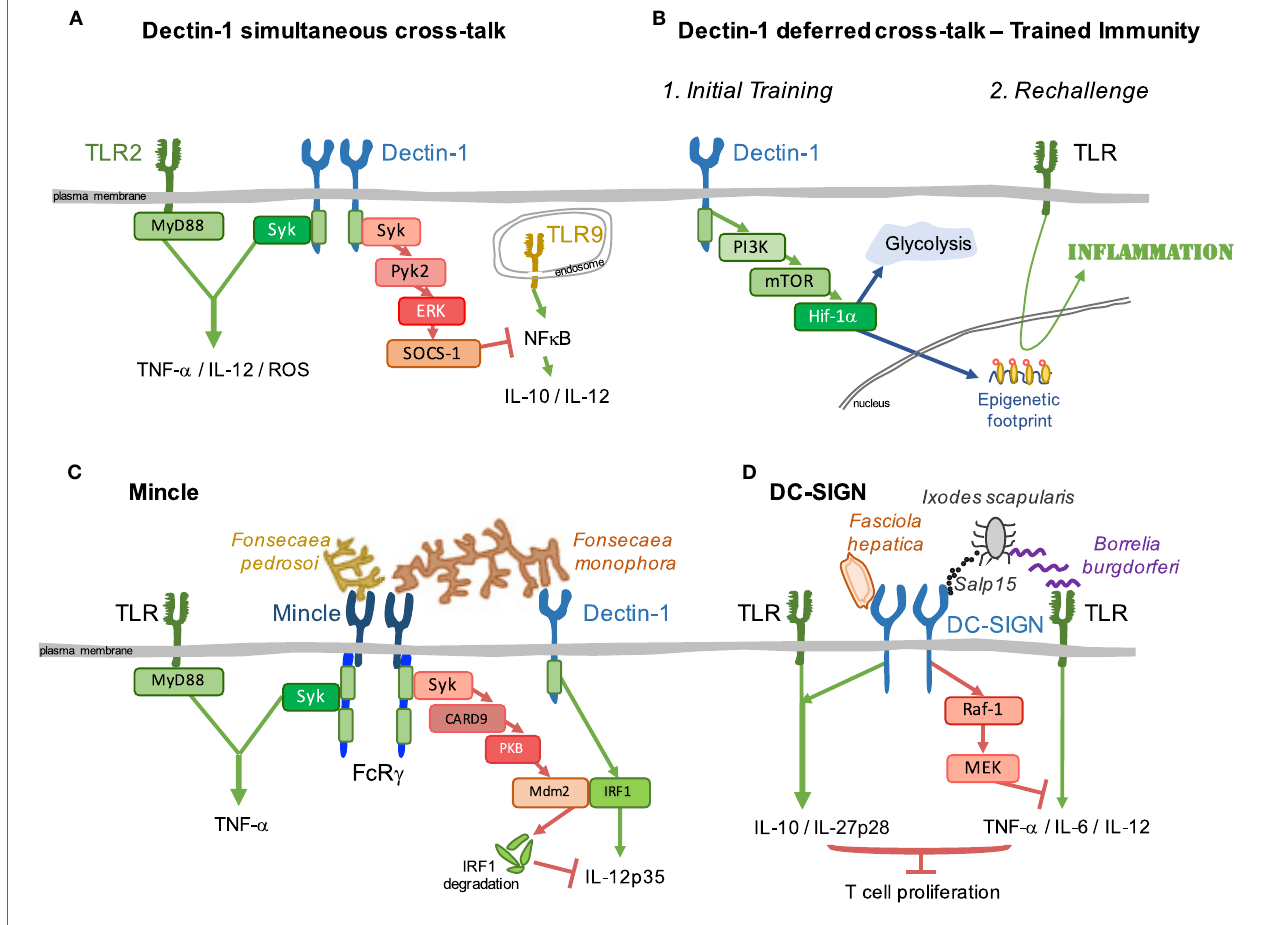
FiGURe 3 | Signaling crosstalk between myeloid C-type lectins and heterologous receptors. Signaling pathways initiated downstream of C-type lectin receptors (CLRs) interact with surrounding cascades triggered by heterologous receptors. Examples of such crosstalk are illustrated. (A) Dectin-1 coordinates with simultaneous signals from diverse TLRs to modulate the inflammatory response; this interaction can be either positive, as for TLR2/MyD88 (left), or negative, as for TLR9 through a Pyk2/ERK/SOCS-1-dependent pathway (right). (b) In addition, the axis Dectin-1/PI3K/mTOR/Hif-1 α generates a switch toward glycolytic metabolism together with an epigenetic footprint, allowing for a “deferred” improved response to TLRs, boosting the inflammatory response. This process is known as trained immunity. (C) A full inflammatory response against Fonsecaea pedrosoi is achieved by synergistic stimulation between Mincle and ligands for TLRs coupled to the MyD88 adaptor (left). However, simultaneous recognition of Fonsecaea monophora by Mincle and Dectin-1 triggers a Mincle-PKB-Mdm2-dependent degradation of Dectin-1-activated IRF1, dampening the expression of protective IL-12p35 (right). (D) DC-SIGN recognition of Fasciola hepatica enhances TLR-induced IL-10 and IL-27p28 (left). Moreover, DC-SIGN sensing of the salivary protein Salp15 from the tick vector Ixodes scapularis dampens inflammatory responses triggered by Borrelia burgdorferi through TLRs (right). Both examples illustrate strategies to escape immune surveillance based on inhibition of T cell